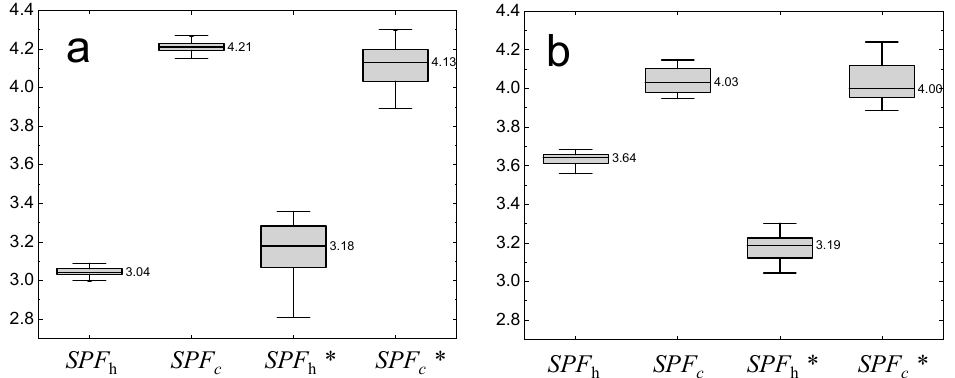
Figure 12. Box plots of seasonal performance factors for heating and cooling in 20-year periods in the present and future and in ( a ) Sapporo and ( b ) Tokyo.